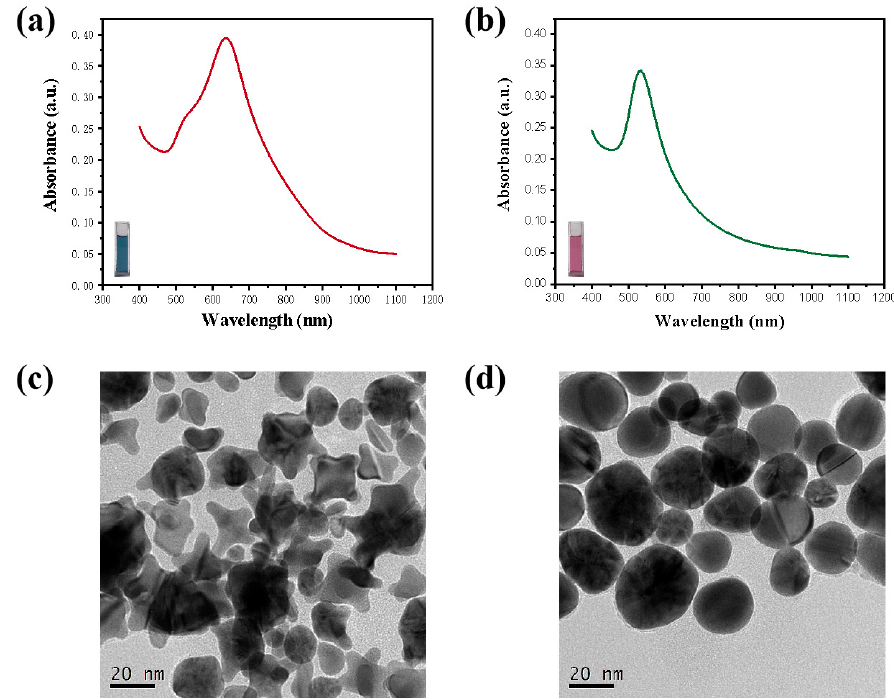
Figure 1. UV – VIS spectra ( a , b ) and transmission electron microscopy (TEM) ( c , d ) images of GNSs prior to ( a , c ) and after ( b , d ) incubation with 2 µM iodide for 90 min.